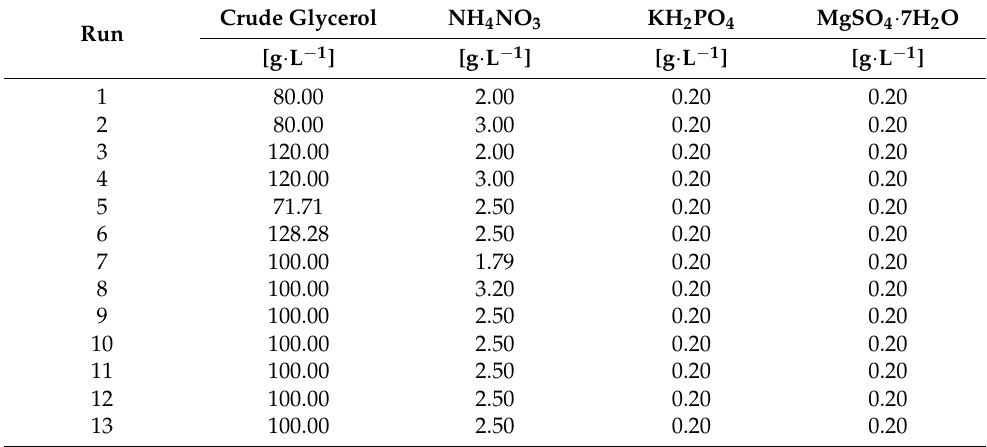
Table 4. Composition of culture media used to optimize the concentration of waste glycerol and ammonium